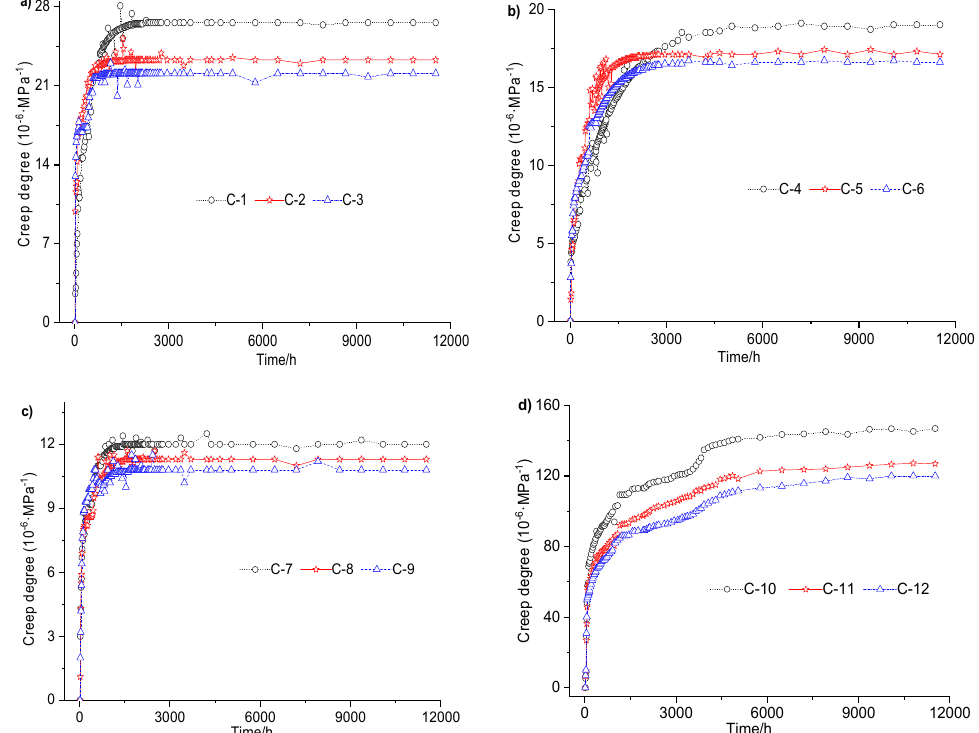
Figure 5. The creep of concrete with three different expanding agent concentrations: ( a ) the steel ratio is 3.8%; ( b ) the steel ratio is 6.6%; ( c ) the steel ratio is 9.2%; ( d ) the steel ratio is 0%.